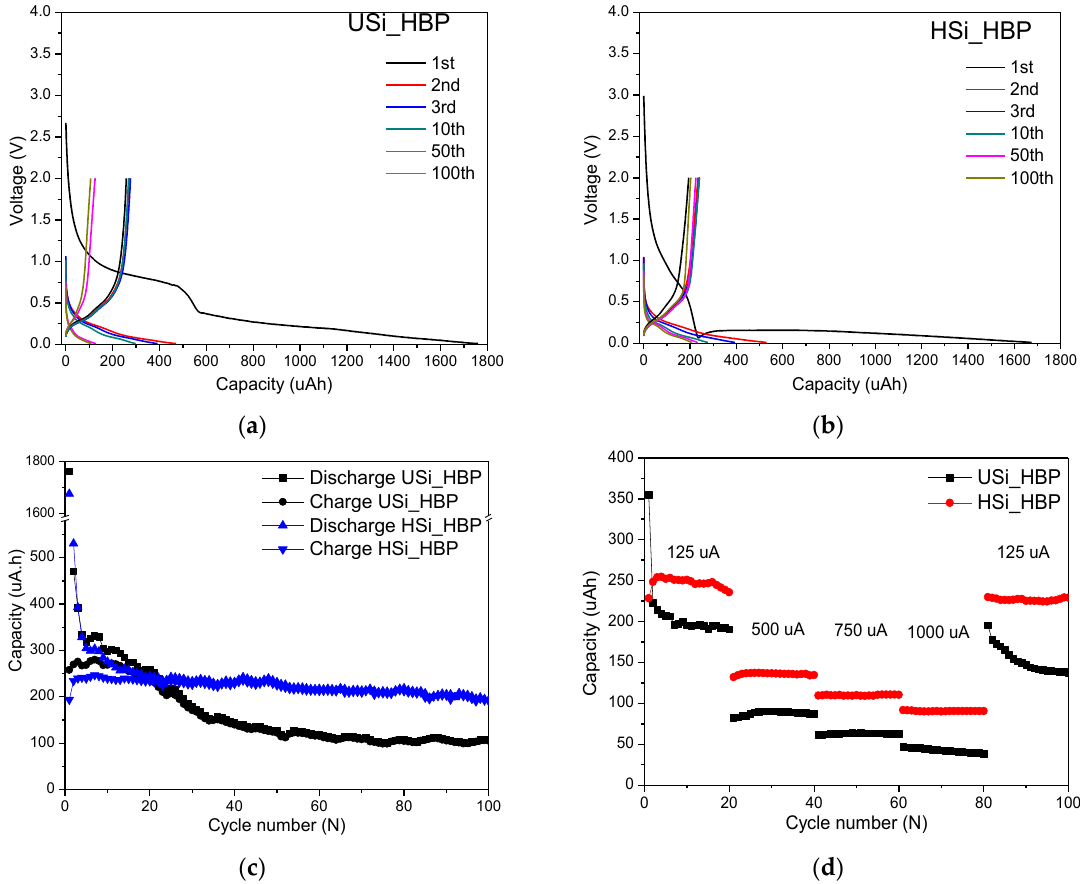
Figure 9. Charge/discharge capacity profiles of ( a ) USi_HBP and ( b ) HSi_HBP, ( c ) discharge/charge cycling performance of electrodes at a current density of 125 μA with the voltage of 0.01–2.0 V, and ( d ) charge cycling performance of heat-treated Si electrodes at progressively increasing current densities from 125 to 1000 μA.